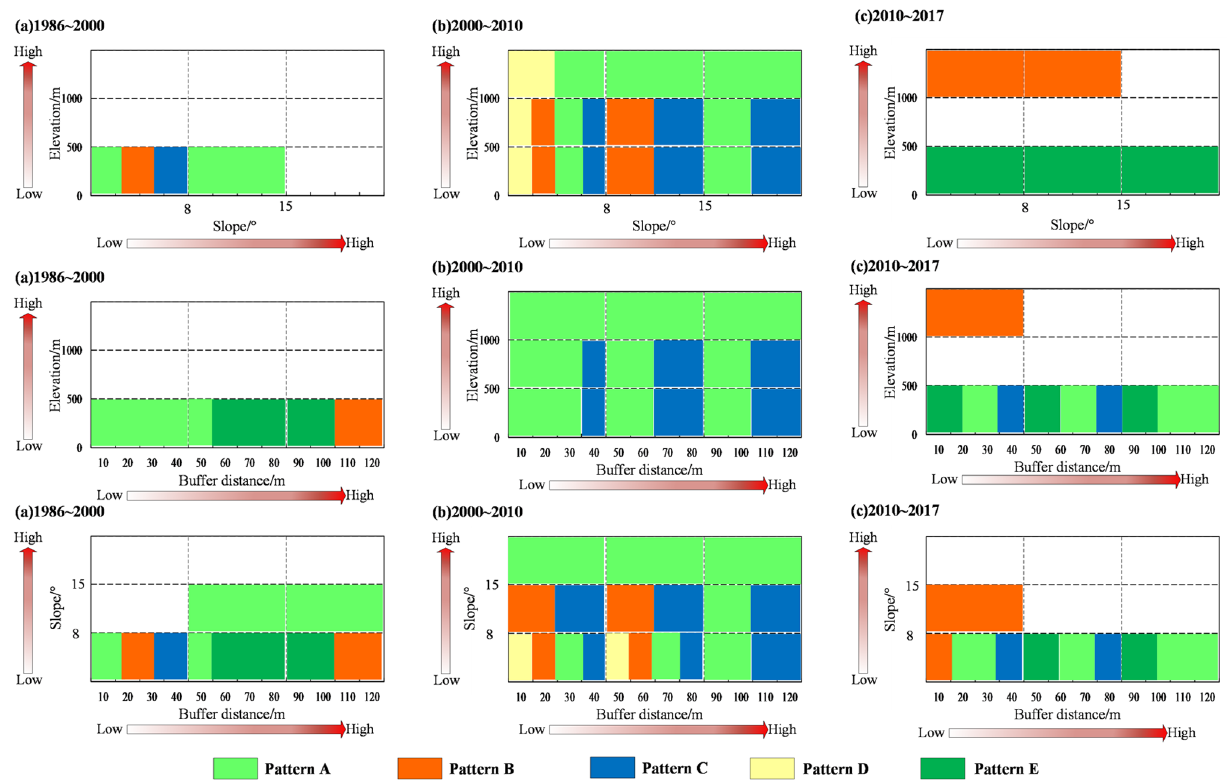
Figure 11. Landscape evolution model in a typical watershed of the TGRA. Pattern A: conversion of other landscape types to forestland; Pattern B: conversion of other landscape types to built-up areas; Pattern C: conversion of other landscape types to water bodies; Pattern D: conversion of other landscape types to farmland; Pattern E: conversion of other landscape types to